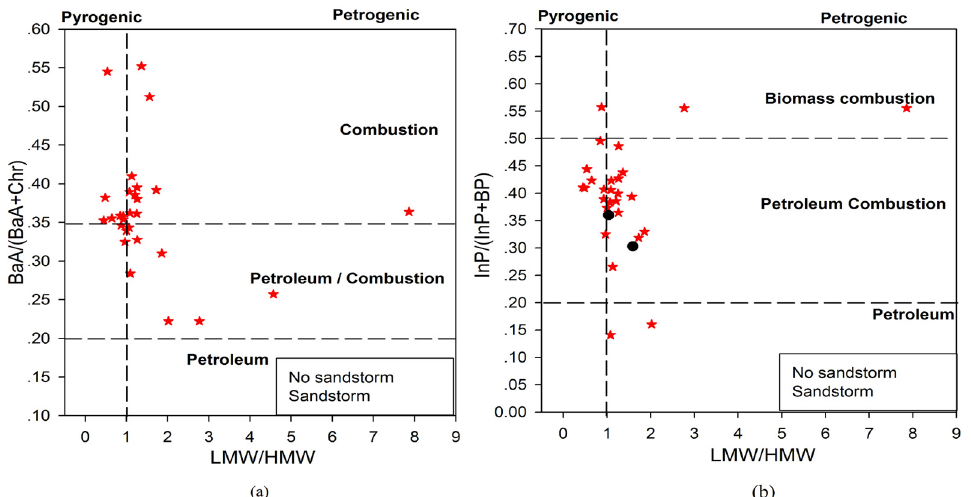
Figure 5. The ratios of LMW/HMW PAHs versus the ratios of BaA/(BaA + Chr) ( a ) and InP/(InP + BP) ( b ) in PM 2.5 for source